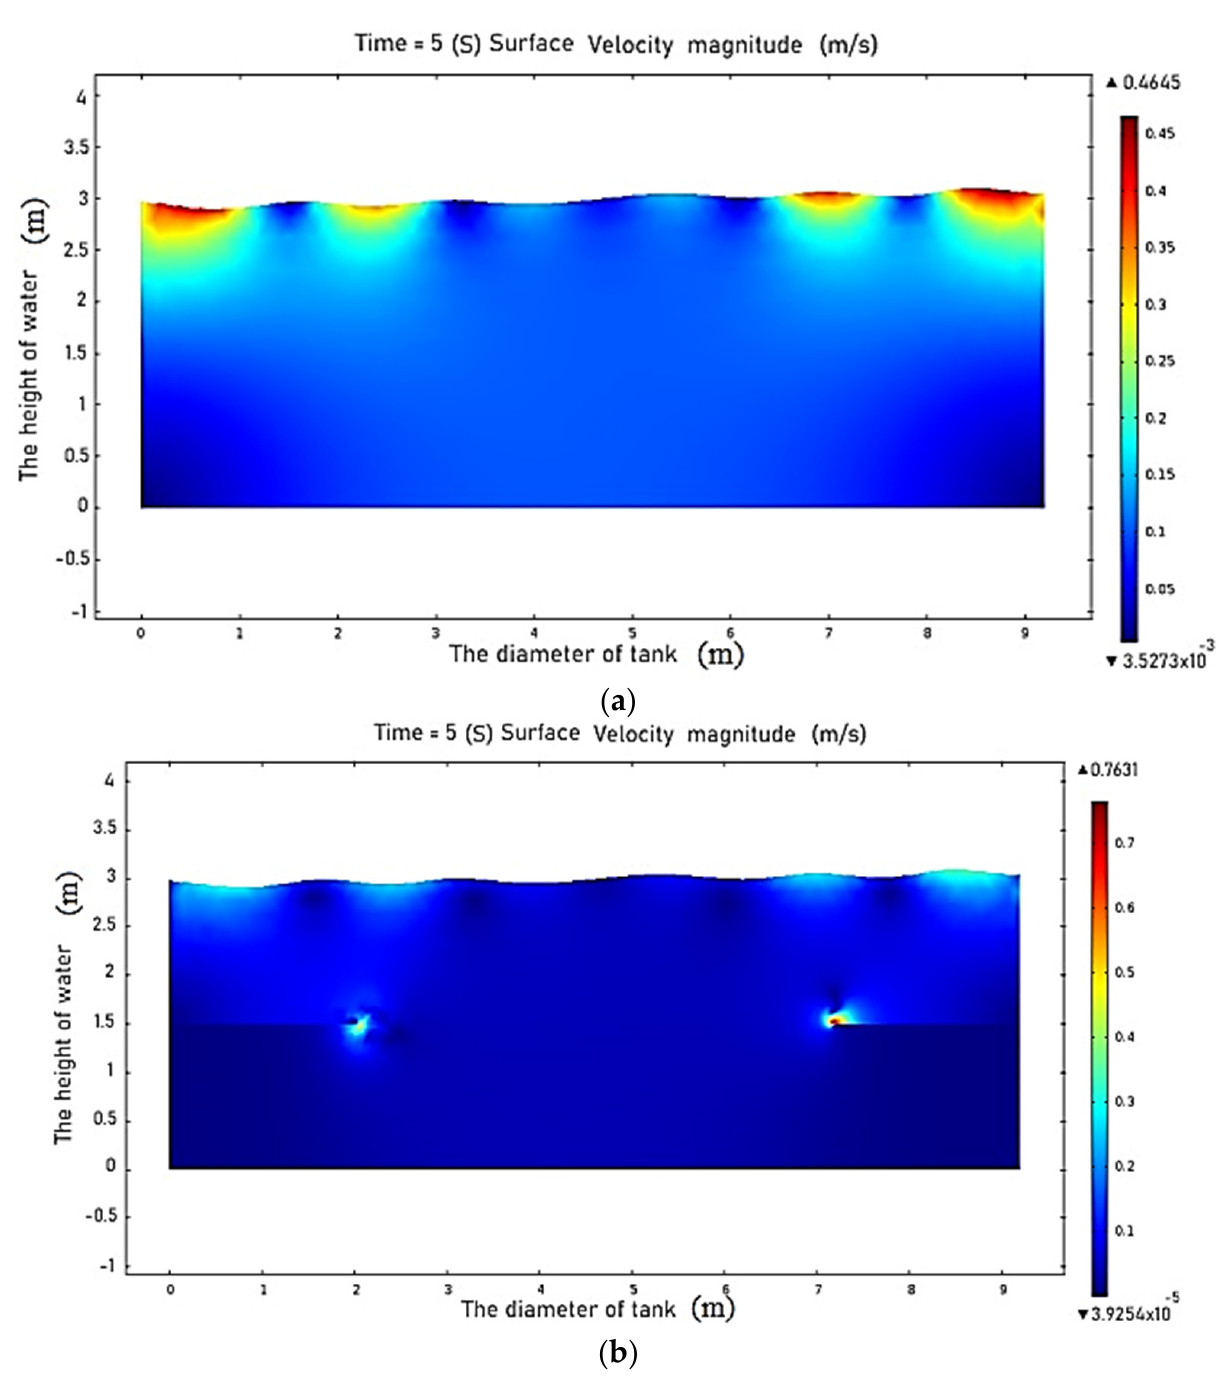
Figure 10. Two-dimensional diagram sloshing of the fluid surface with/without baffle. ( a ) Two- dimensional diagram of no baffle sloshing of the fluid surface at T = 5 (s); ( b ) two-dimensional diagram of the baffle sloshing of the fluid surface at T = 5